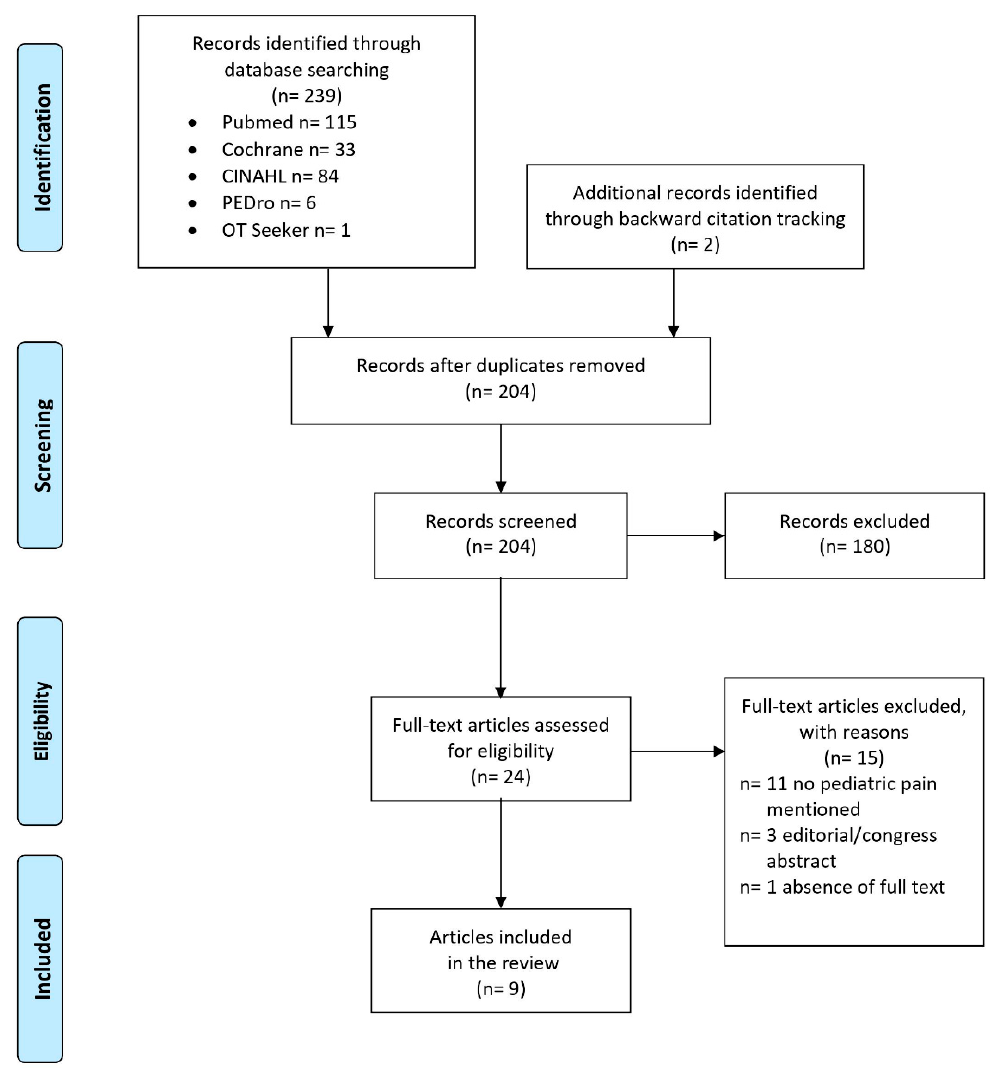
Figure 2. Flowchart of the study selection process.